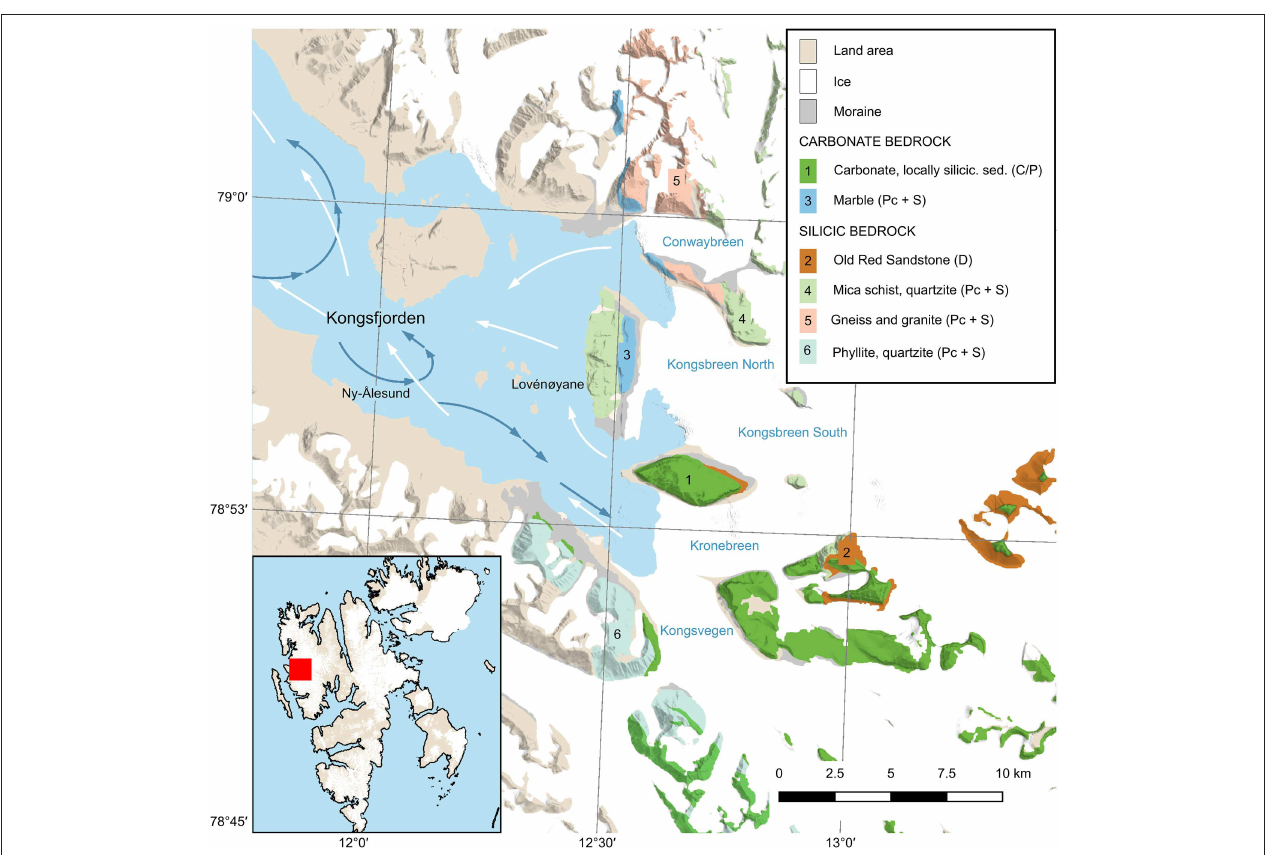
FIGURE 1 | Kongsfjorden, Svalbard, with bedrock geological units relevant for this study: carbonate (1), Old Red Sandstone (2), marble (3), mica schist (4), gneiss and granite (5) phyllite, and quartzite (6). Stratigraphic ages for the units are given in parentheses: (C/P) = Carboniferous/Permian; (Pc + S) = Precambrian + Silurian, (D) = Devonian. Arrows indicate currents based on Hop et al. (2019), blue shows deep fjord water, and white surface water. Geological map is based on data from the Norwegian Polar Institute ( Dallmann,